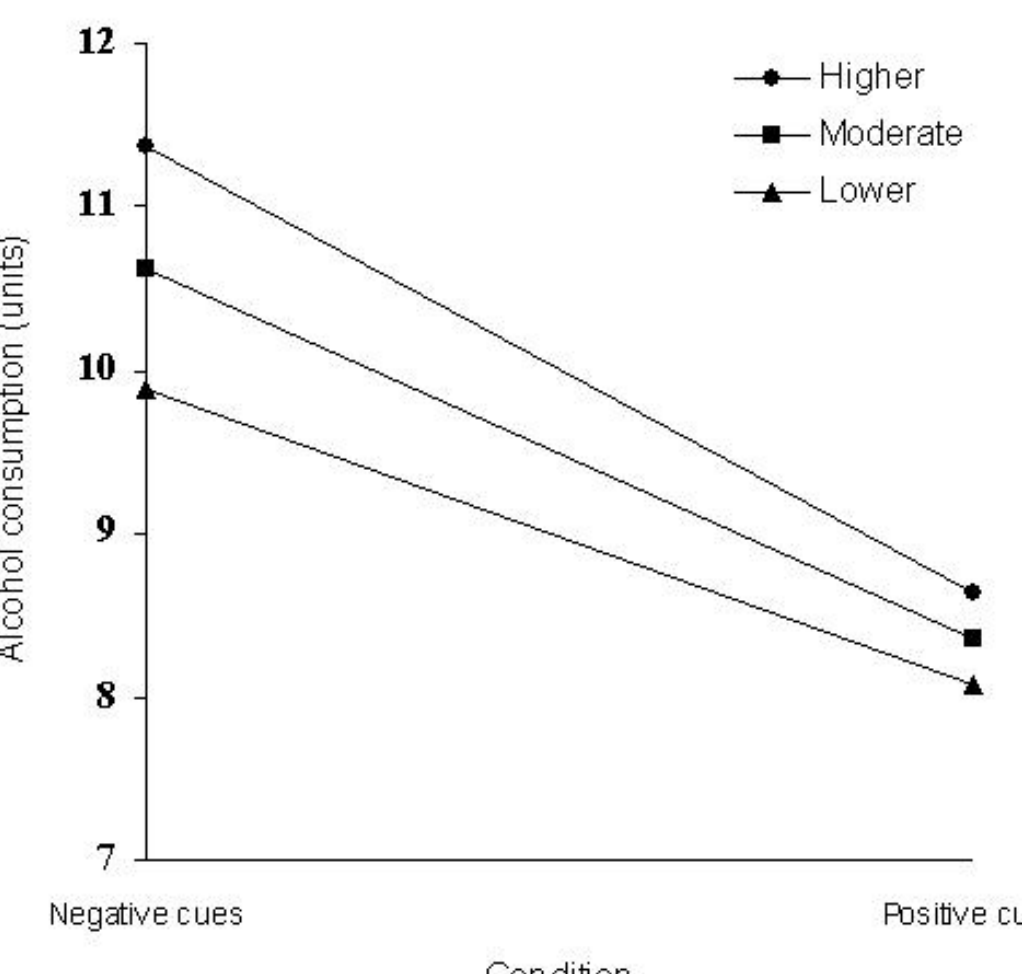
Figure 1. Simple slopes for the interaction between condition and baseline alcohol consumption on alcohol consumption at 1 week follow-up; simple slopes have been calculated at mean (moderate consumption), +1 standard deviation (higher consumption), and −1 standard deviation (lower